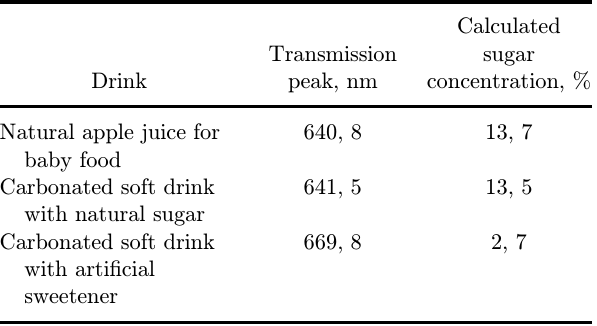
Table 1. Determination of sugar content in di®erent drinks.